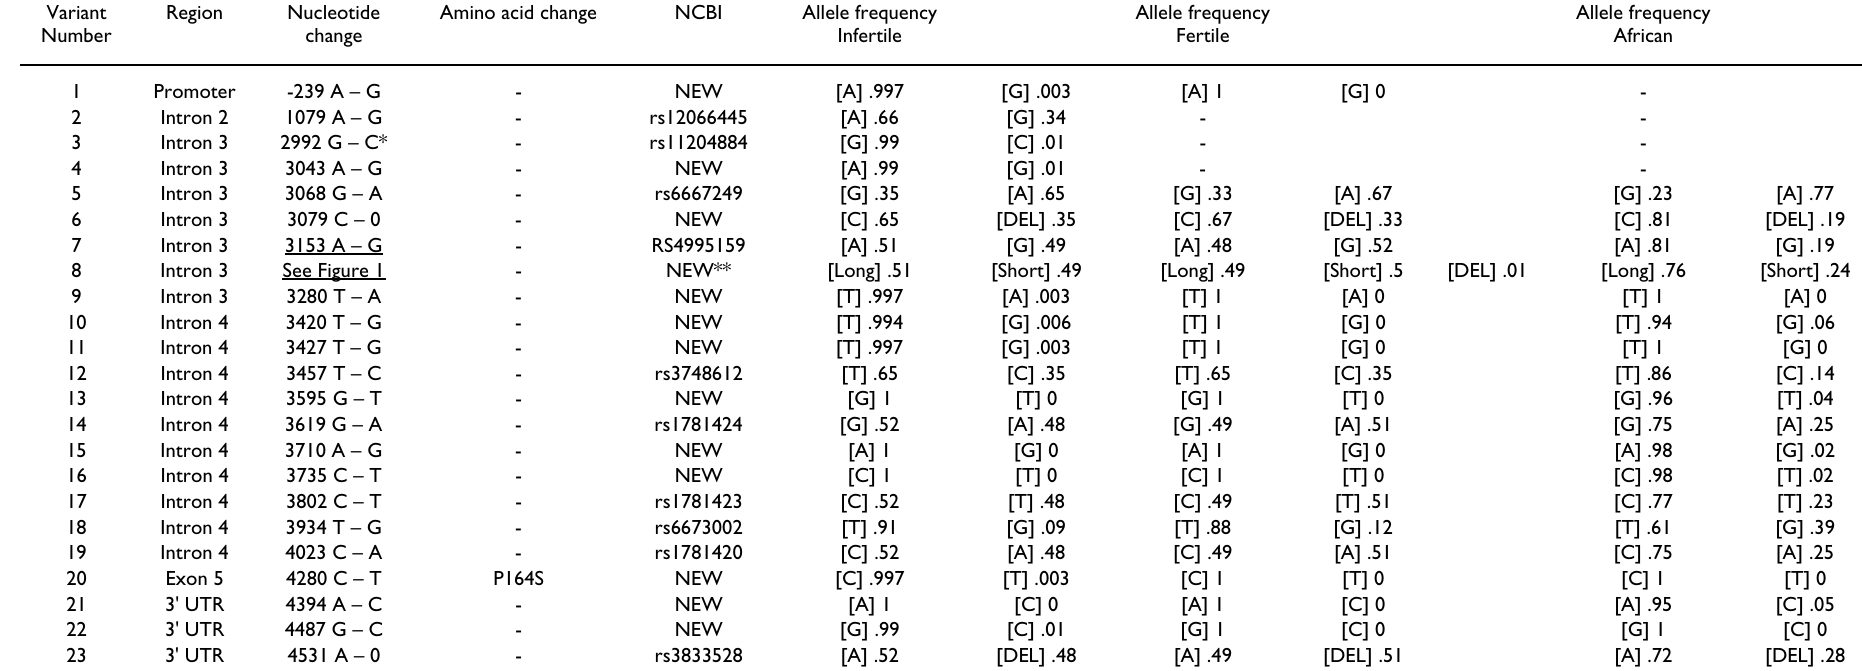
Table 2: Nucleotide variants detected in the human OAZ3